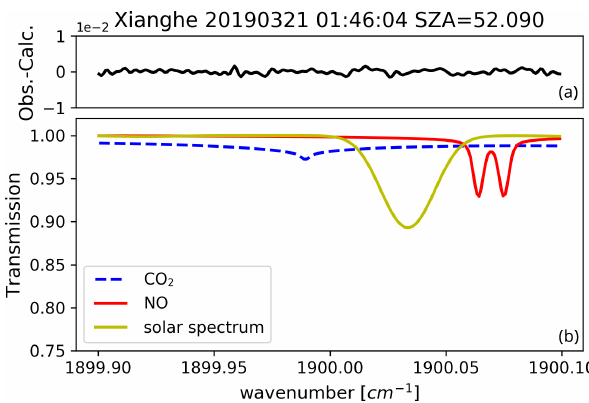
Figure 1. An example of the transmittances from NO, carbon dioxide (CO 2 ), and solar lines (b) and the difference between the observed and calculated spectra (a) in the NO retrieval window (1899.9–1900.1cm − 1 ) at Xianghe. The measurement time (UTC) together with the solar zenith angle is shown in the